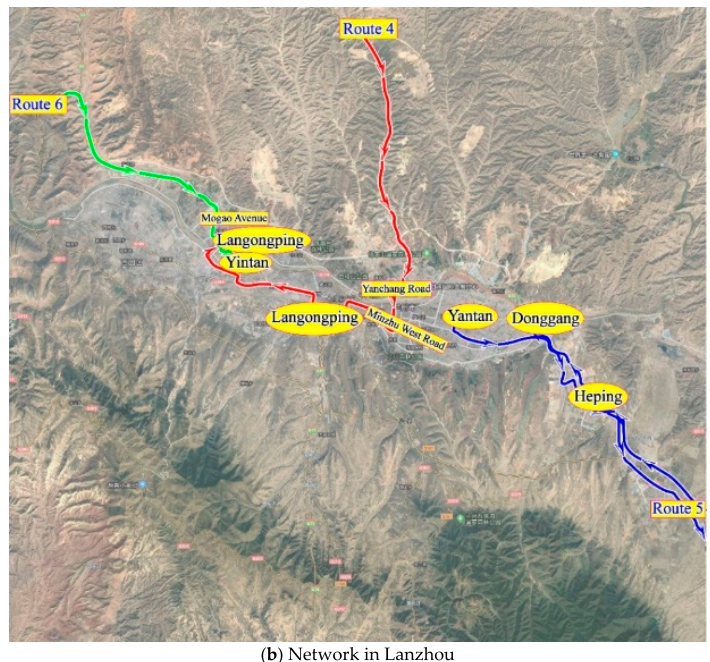
Figure 3. Hazardous material optimal transportation networks generated by the platform. Table 5. Hazardous materials optimal transportation plan based on the proposed method (plan A). Distribution